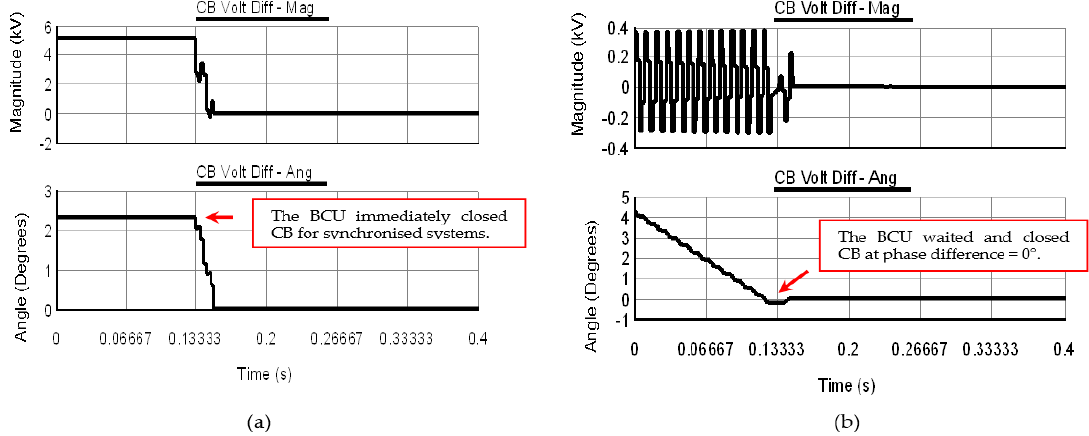
Figure 10. RTDS monitored voltage differences across CBs during reclosing: ( a ) Bay 2 (without slip) and ( b ) B Bay 3 (with a slip frequency = 0.1 Hz).